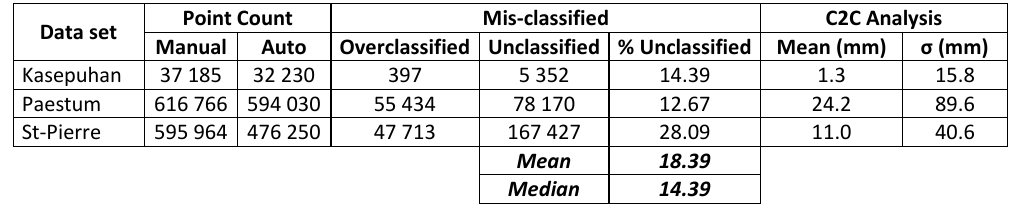
Table 2. Segmentation statistics for the three data sets, also showing a cloud-to-cloud analysis which used the manually segmented clusters as reference.